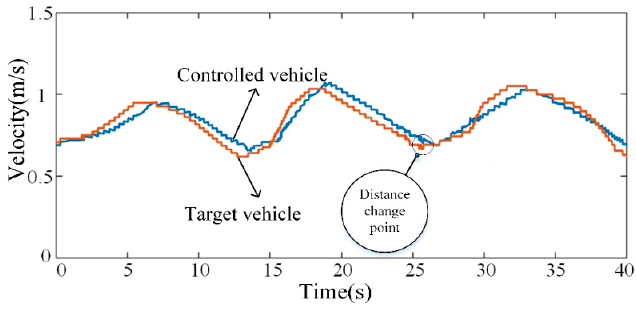
Figure 10. Following velocity diagram.